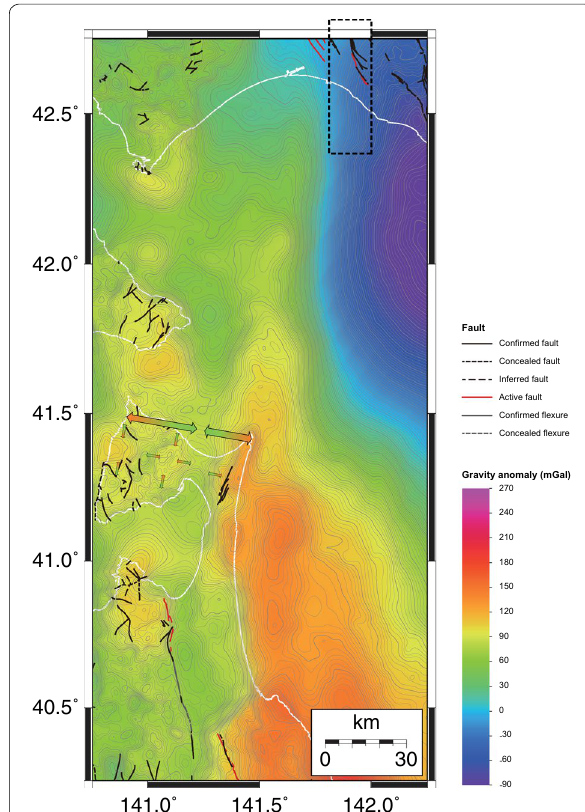
Fig. 4 Bouguer anomaly map for the study area (modified from Geological Survey of Japan, 2013). A density of 2.67 g/cm 3 was used for calculating Bouguer anomalies. The contour interval is 2 mGal. The white line shows the coastline. The black dashed rectangle indicates the distributional range of the aftershocks used in the stress tensor inversion by Ohtani and Imanishi (2019). The big double arrows indicate the locations of large-scale N–S-striking structure (Yamamoto 2005). There are many small-scale structures, among which some are shown with small double